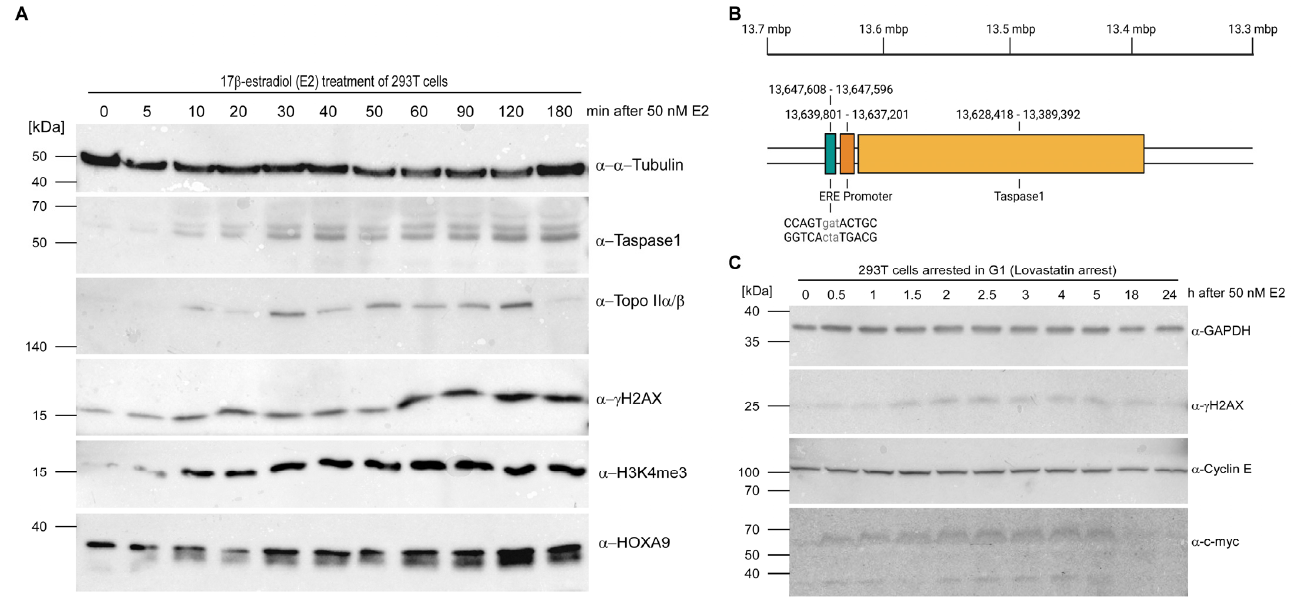
Figure 2. TASP1 is an estrogen-responsive gene. ( A ) Programmed DNA DSBs appear shortly after treatment of 293T cells with E2. Topo II and Taspase1 are synchronously upregulated as detected by immunoblot. ( B ) Visual representation of the identified Estrogen Response Element (ERE) located 7.8 kbp upstream of the TASP1 promoter. TASP1 gene and flanking region up to − 10 kb were screened for a plethora of different EREs. This illustration was created with BioRender.com. ( C ) E2 treatment of G1-arrested cells also provokes an increase in DSBs indicating that the emerging DSBs reflect the phenomenon of hormone-induced transcriptional activation via Topo II β -mediated DSBs instead of replication-associated DNA lesions.